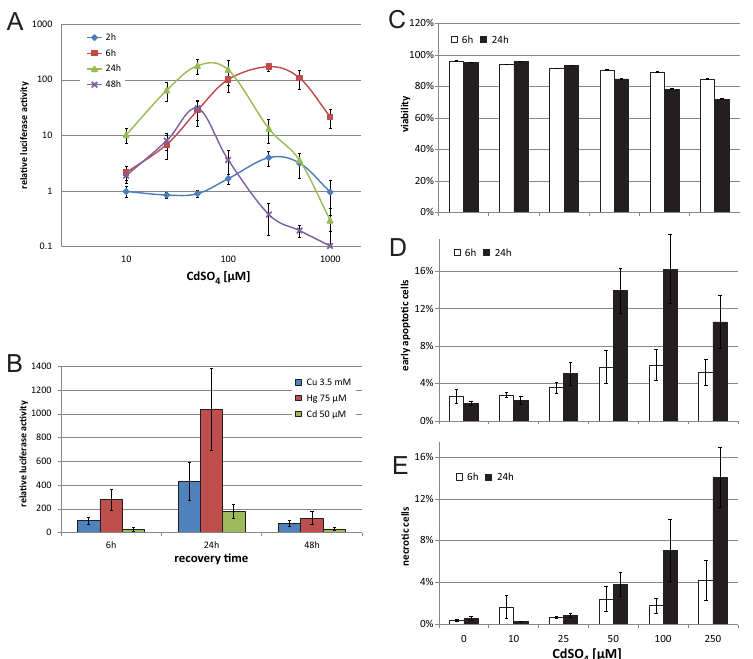
Fig 1. Heavy metal induced HSR in C5 cells. (A) C5 cells were treated with the indicated concentrations of CdSO 4 in DMEM complete for 1 h. Then the cells were washed once and recovered in DMEM complete for different time points (2, 6, 24, 48 h). Y-axis shows relative luciferase activity compared to untreated control cells. (B) C5 cells were treated with CdSO 4 (Cd, 50 μ M), CuSO 4 (Cu, 3.5 mM) or HgCl 2 (Hg, 75 μ M) in DMEM complete for 1 h. Then the cells were washed once and recovered in DMEM complete for 6, 24 or 48 h. Y-axis shows relative luciferase activity compared to untreated control cells. (C-E) For viability assay with flow cytometry, HEK293 cells were treated with different concentrations of CdSO 4 in DMEM complete for 1 h. Samples were taken after 6 h and 24 h, then stained with AnnexinV-FITC and 7-AAD. Y-Axis shows percentage of viable cells (no 7-AAD staining) compared to total cell count (C), early apoptotic cells, positive for AnnexinV-FITC (D) and of necrotic cells, positive for 7-AAD (E). All values show means of at least three independent experiments, luciferase measurements were performed with 6 technical replicates each. Error bars indicate